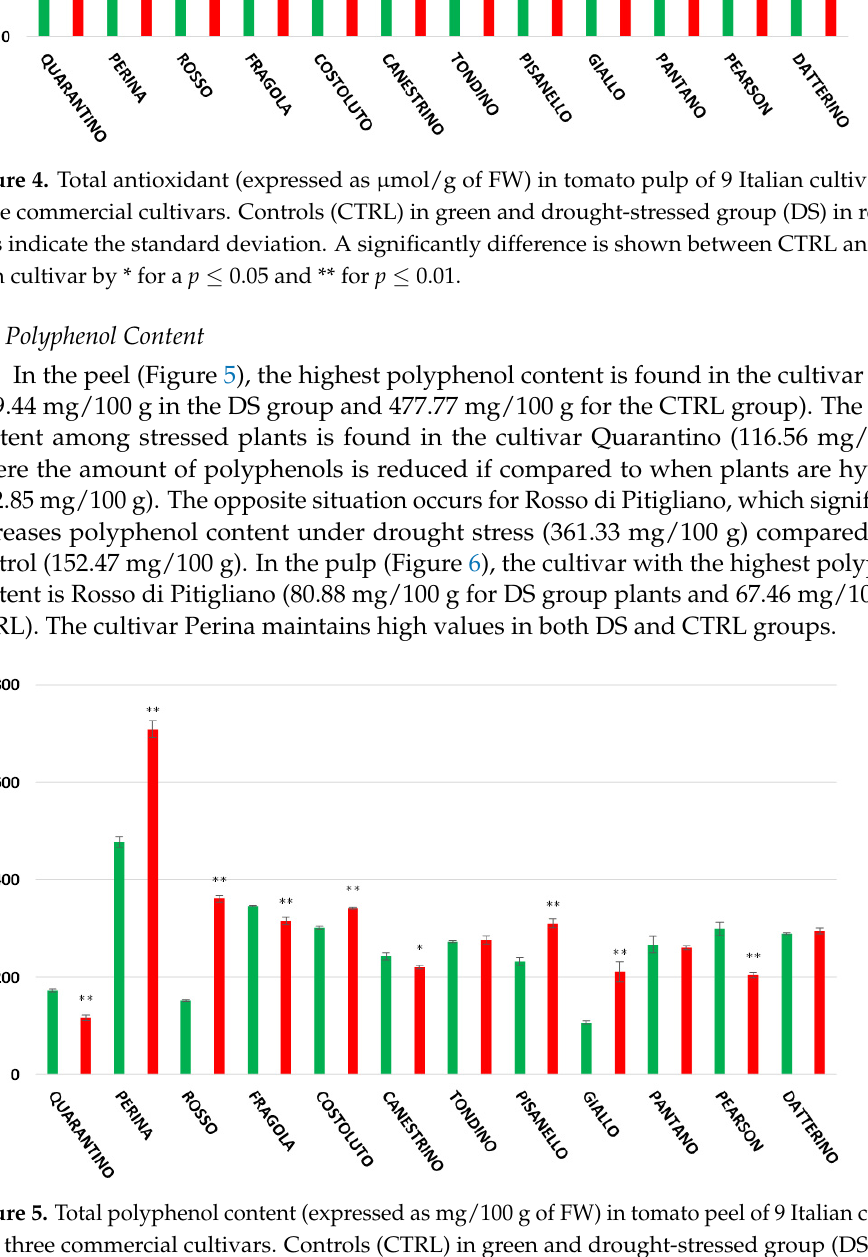
Figure 6. Total polyphenol content (expressed as mg/100 g of FW) in tomato pulp of 9 Italian culti- vars and three commercial cultivars. Controls (CTRL) in green and drought-stressed group (DS) in